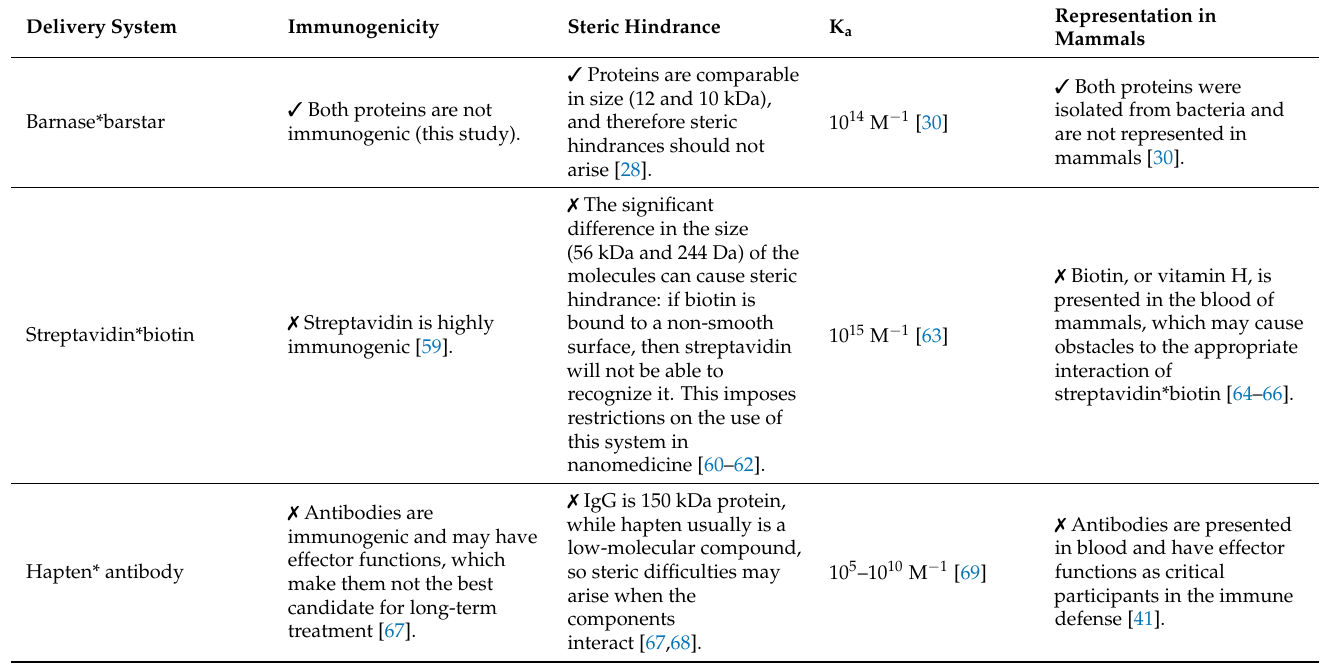
Table 1. The interfaces used for the drug delivery systems with pre-targeting steps ( (cid:51) —advantages, (cid:55)